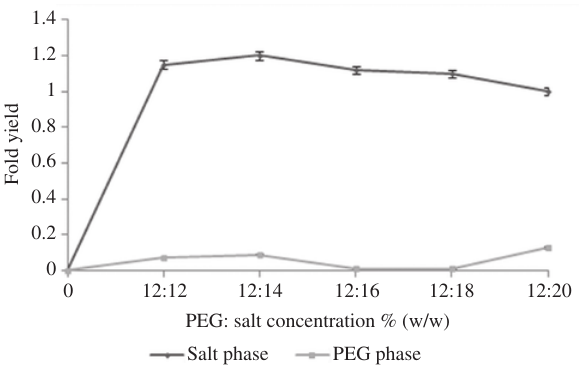
Figure 3: Effects of PEG concentration on fold yield. pH 4.0 and temperature 30 °